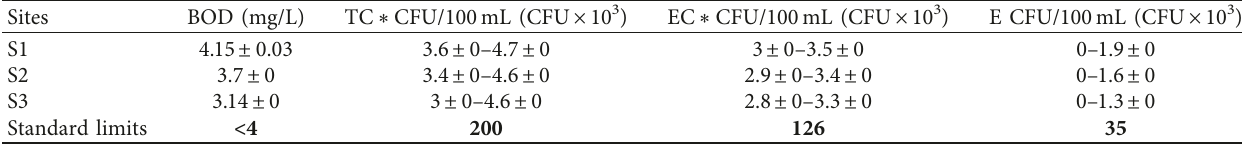
Table 1: Bacteriological parameters of the Al-Hillah River in three sampling sites.